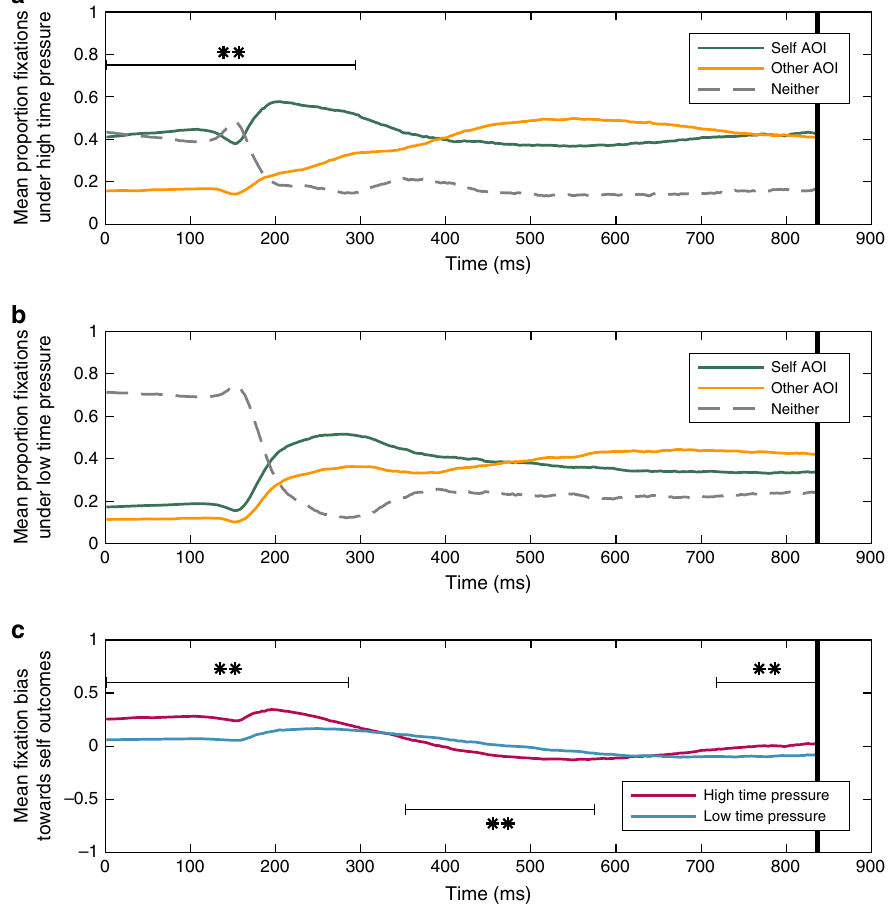
Fig. 3 Attention dynamics of altruistic choice across time. Millisecond-to-millisecond proportion of gaze directed to Self AOI, Other AOI or neither under a high time pressure, and b low time pressure. c The difference in proportion of trials with gaze position in Self AOI and Other AOI under high and low time pressure. Lines are coloured by AOI. Bars with asterisks (**) denote time periods (clusters) of permutation-corrected signi fi cance (cluster t greater than 95% of simulated t max ) at a threshold of two-tailed p < 0.01 for z -tests of the logistic mixed-effects model parameters: a , b intercept and c main effect of time pressure. Comparisons were conducted up until 837 ms, after which >50% of trials terminated under the high time pressure condition. Source data are provided as a Source Data fi